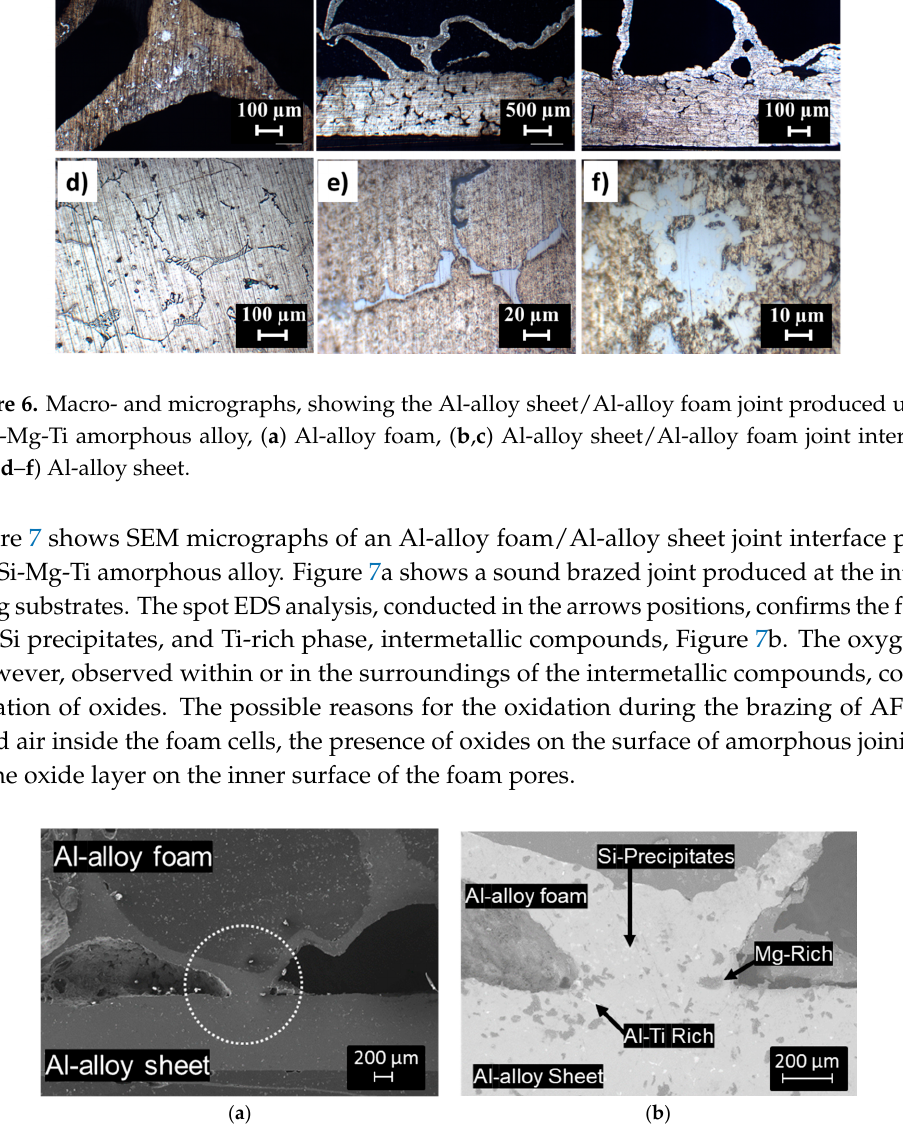
Figure 7. SEM and back-scattered images of Al-alloy foam/Al-Mg-Si-Ti/Al-alloy sheet interface. ( a ) Micrograph in secondary electron mode. ( b ) Micrograph in backscattered electron mode. Arrows indicate spot EDS